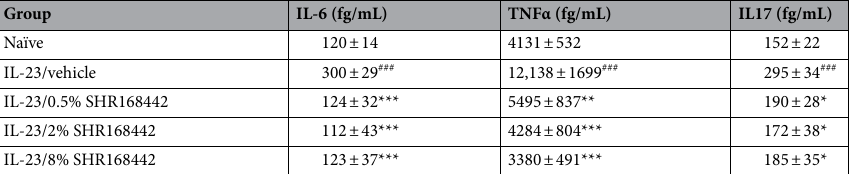
Table 4. Effects of SHR168442 in Vaseline on production of multiple cytokines via topical route (Mean ± SEM, n = 10). Data were analyzed by one-way ANOVA. ### p < 0.001 versus naïve group. * p < 0.05, ** p < 0.01, *** p < 0.001 versus IL-23/vehicle